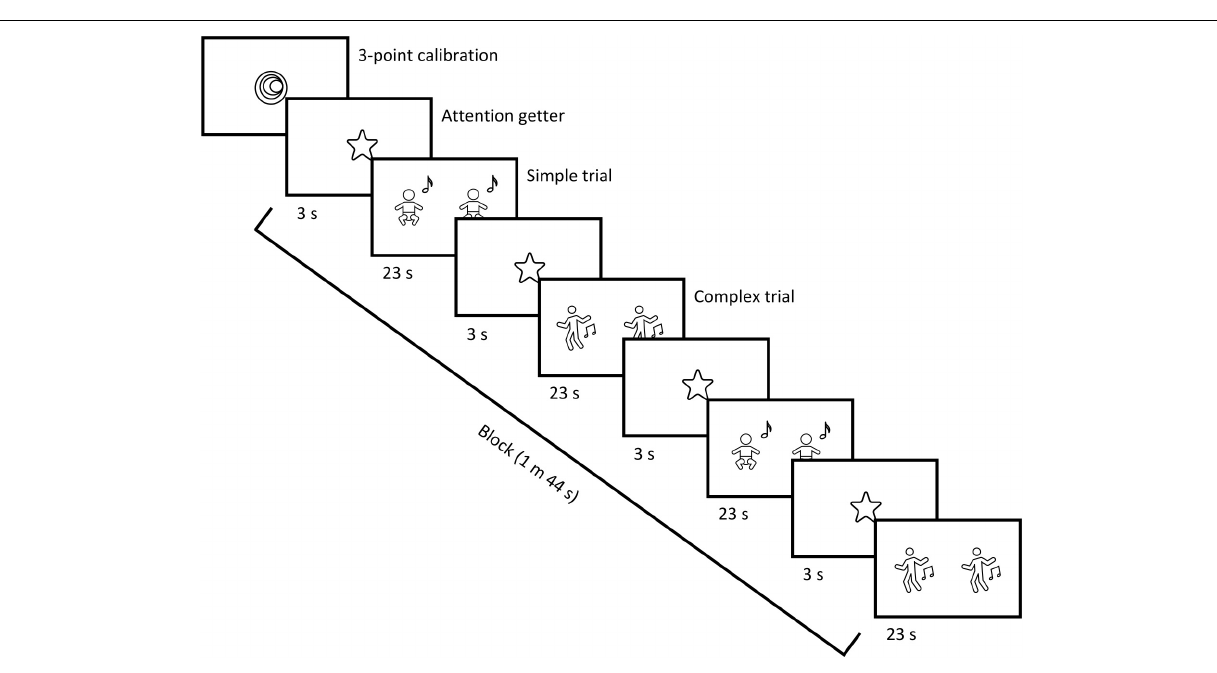
FIGURE 2 | Experimental block (duration: 1 m 44 s). Each block consisted of four trials, two simple and two complex ones. Participants saw 12 trials in total, administered in three blocks (corresponding to one list). Trial duration was 23 s, and each trial was preceded by a 3-s-long, infant-friendly attention getter (spinning star). Trials within a block and list were alternated based on condition (simple/complex), to avoid consecutive repeats of trials from the same condition. The position of the synchronous stimulus (left/right) was pseudorandomized across trials and lists. Prior to the first block, a three-point calibration (with a spinning spiral) was